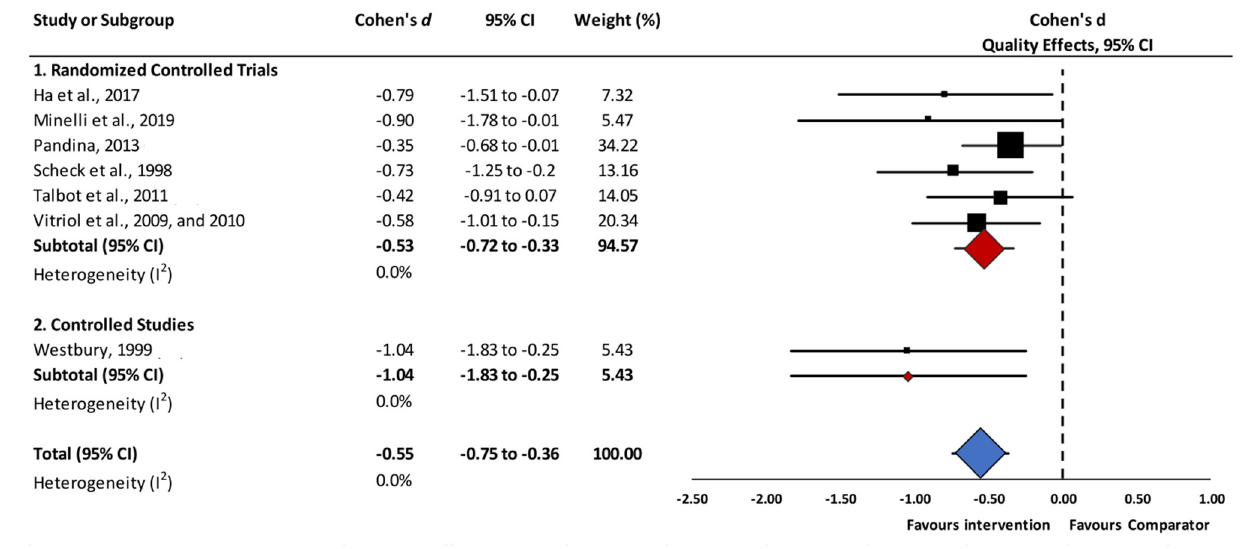
FIGURE 2 | Short-term effects of interventions vs. comparators in reductions of depressive symptoms. Abbreviations. 95% CI, 95% confidence interval. Short-term effects: assessment up to 12-weeks follow-up.